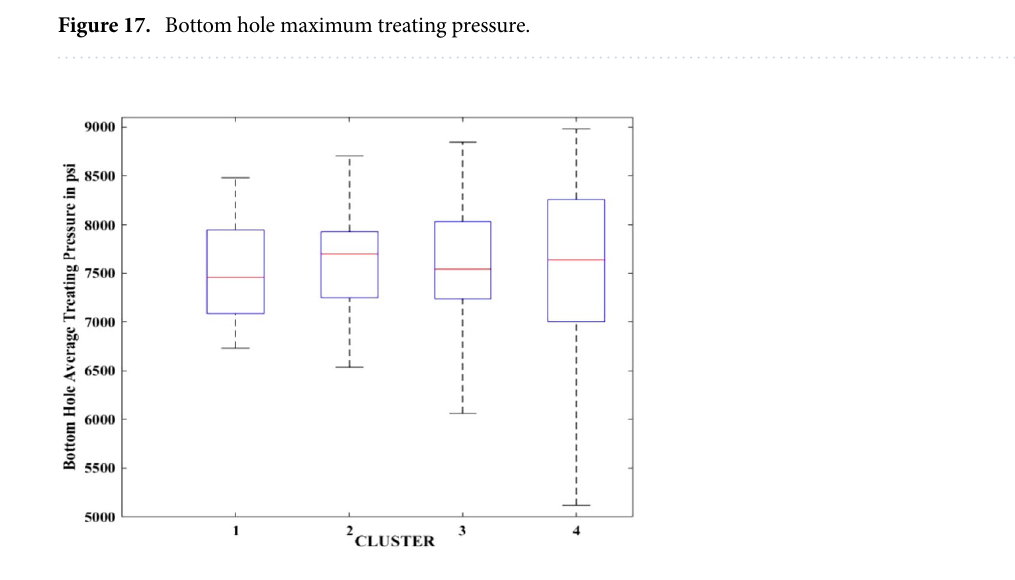
Figure 18. Bottom hole average treating